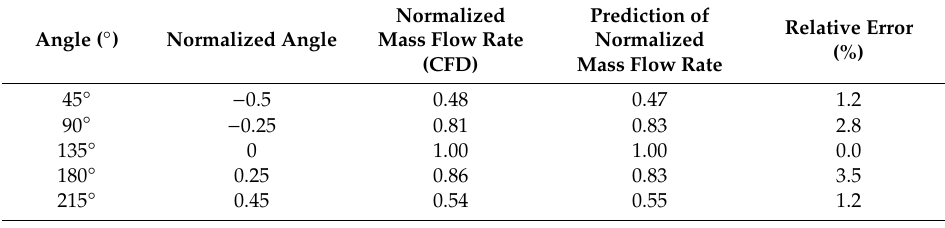
CFD results (red dots). Table 3. Percentage relative error between CFD and empirical normalized airflow rate for 12 m / s.